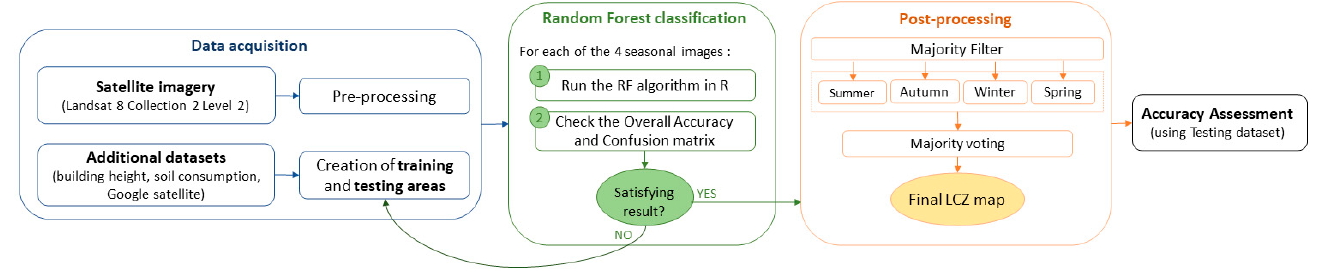
Figure 3. Flowchart followed for LCZ mapping from Landsat 8 images.